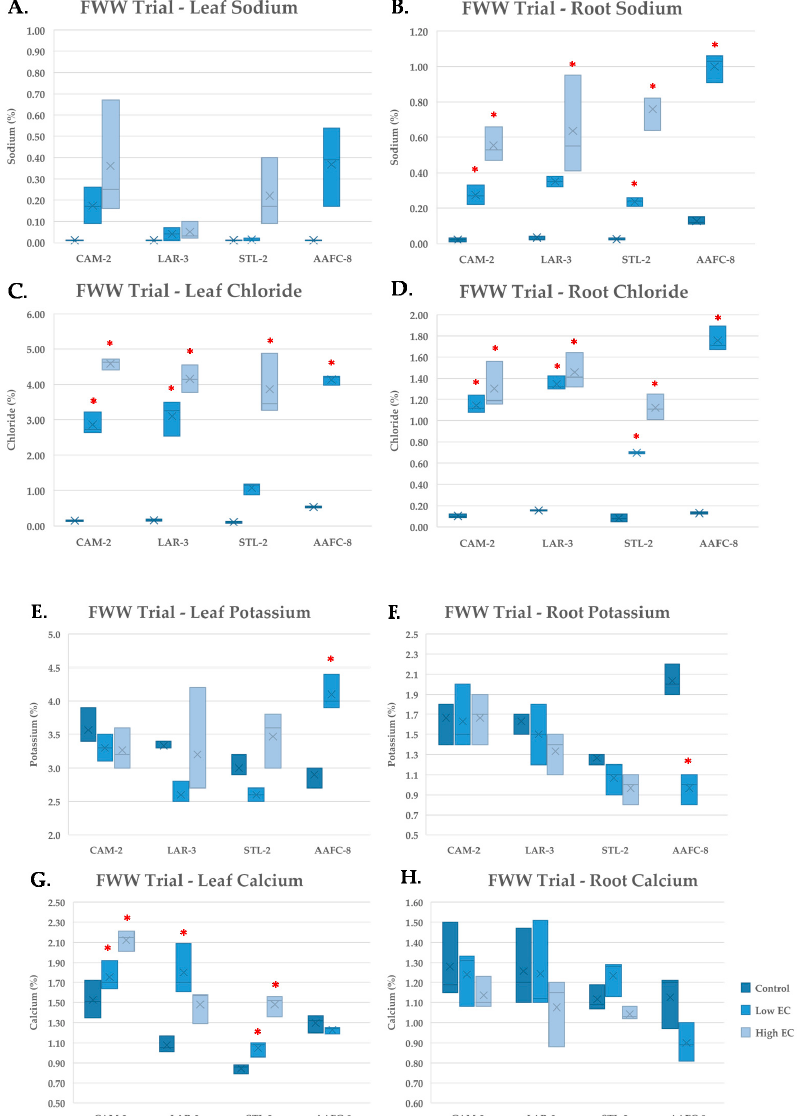
Figure 6. Sodium ( A , B ) chloride ( C , D ), potassium ( E , F ), and calcium ( G , H ) content of leaf ( A , C , E , G ) and root ( B , D , F , H ) tissues ( +/ − SEM) in native and hybrid willow genotypes at the conclusion of the FWW trial treated with control, low, and high fracking wastewater dilutions ( n = 3 for each genotype and treatment). Hybrid willow leaf and root tissues are omitted due to lack of tissue resulting from high mortality rates. Asterisks denote significant di ff erence from control treatment ( p <